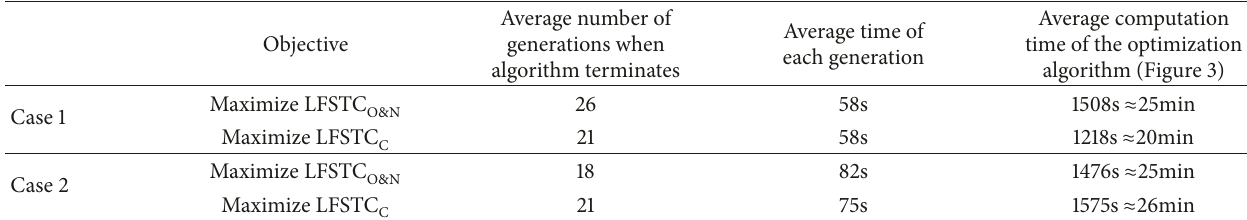
Table 4: Computation time of